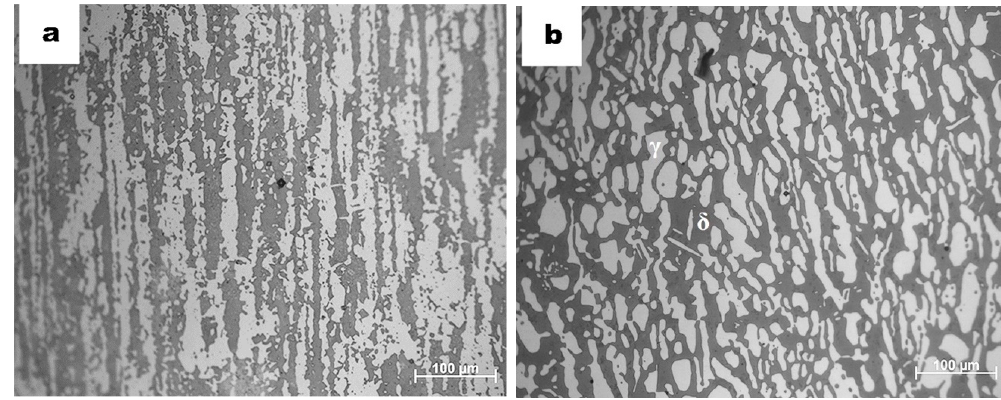
Figure 1. Optical micrographs of DSS ( a ) and SDSS ( b ), after annealing process at 1080 °C for 30 min. Homogenous microstructure of relatively equal distribution of austenite and ferrite phases is shown after being etched by modified Murakami chemical reagent [22].